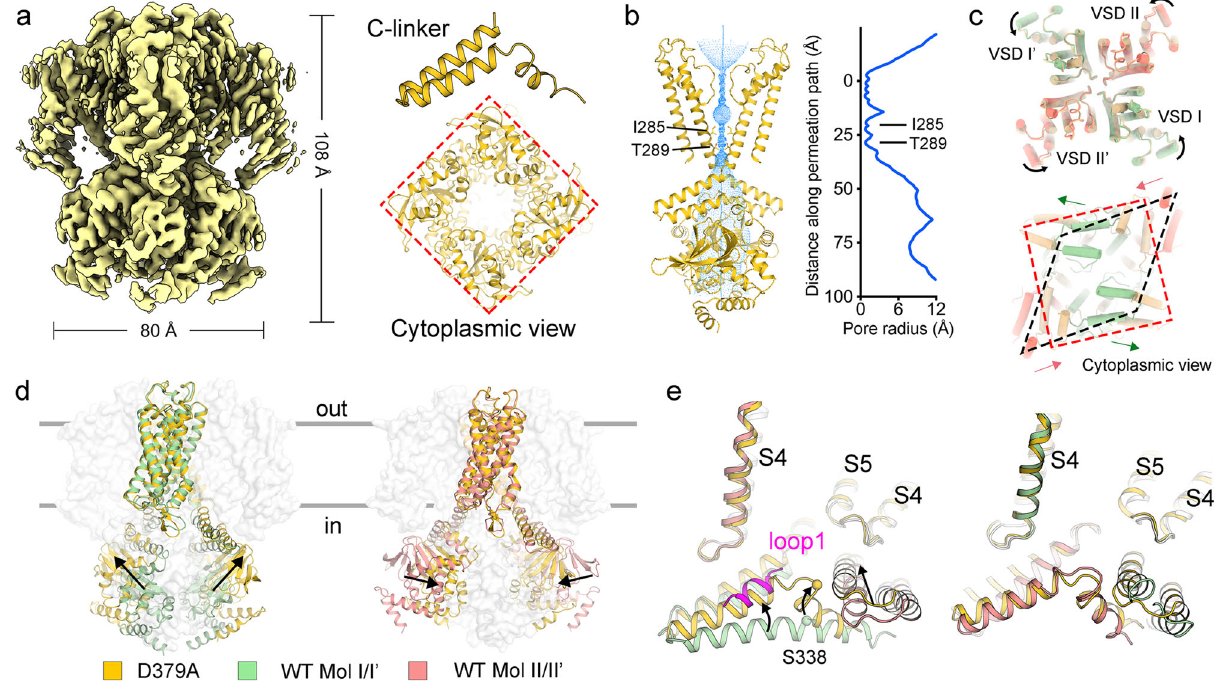
b RadiusoftheporecalculatedbytheHOLEprogram 52 .Theaminoacidsrestricting the inner gate are shown in sticks. c , d Structural comparison of AKT1 in different symmetric conformations. The CNBDs of Mol I/I ’ and Mol II/II ’ undergo dramatic conformational change associated with the symmetry rearrangement. e Conformational changes of C-linkers and loops1/1 ’